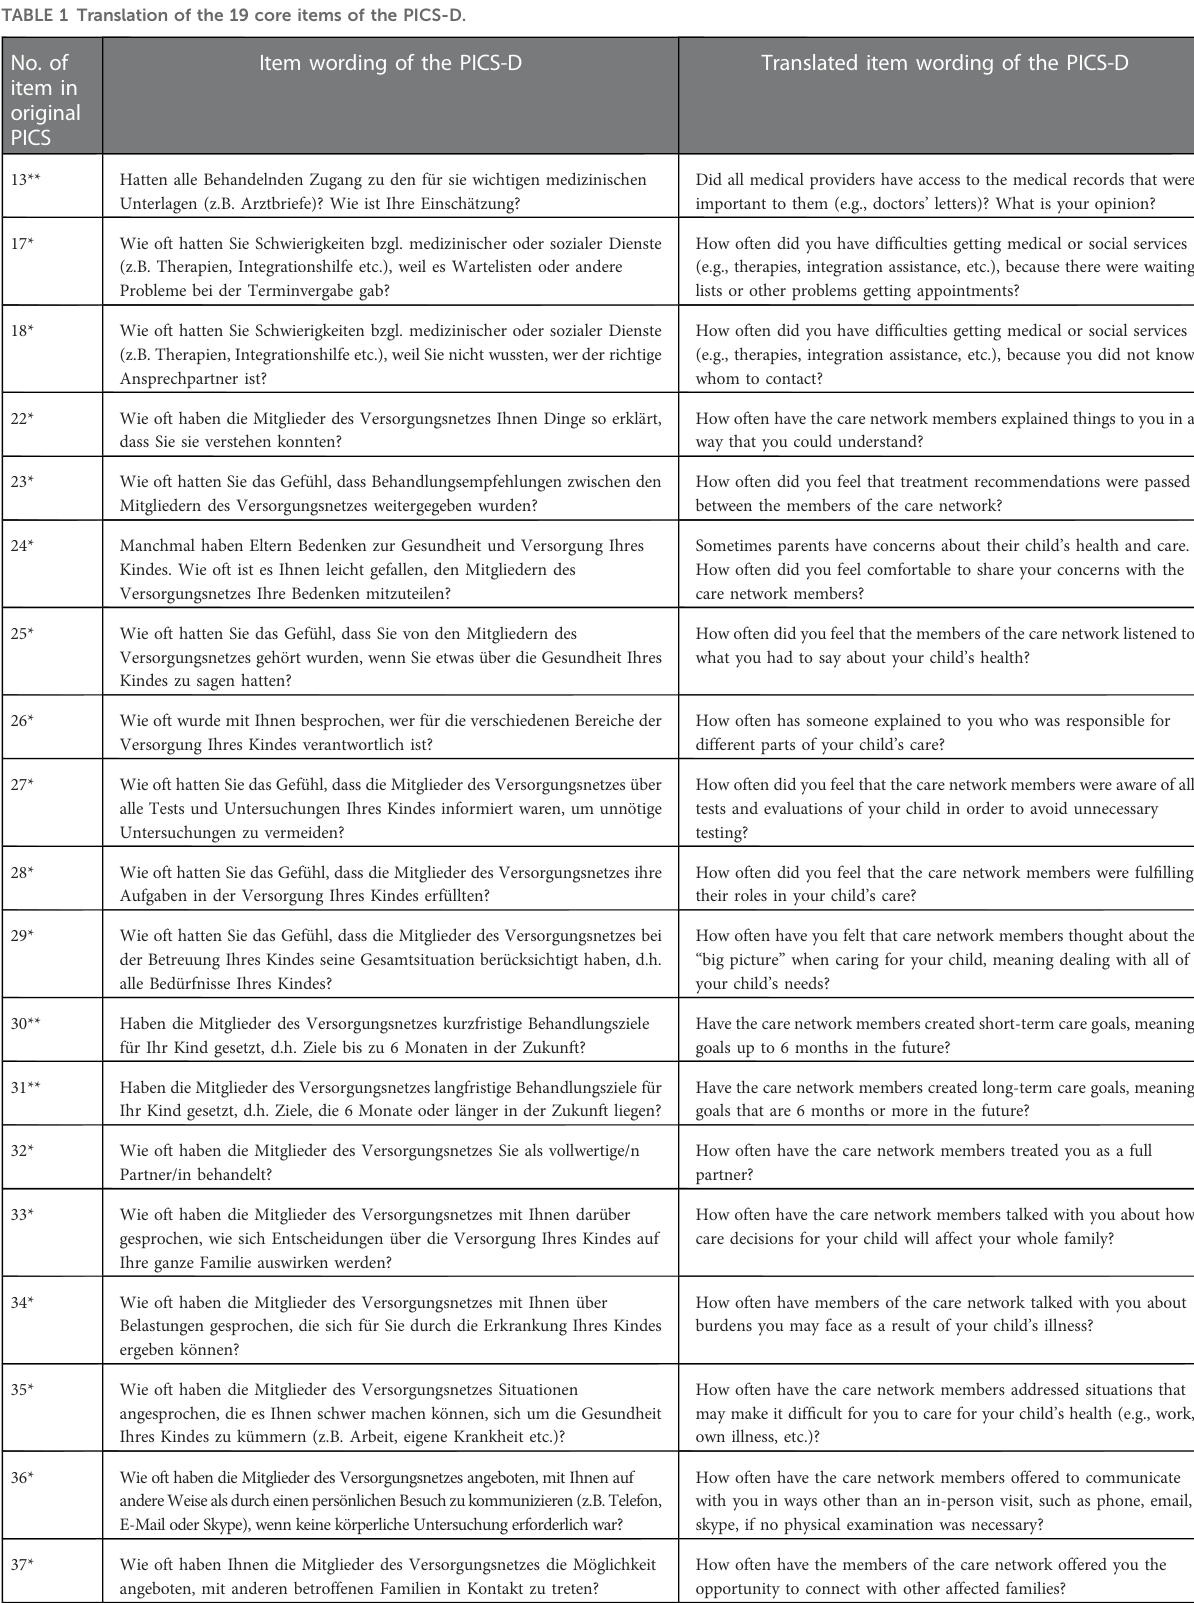
TABLE 1 Translation of the 19 core items of the PICS-D. No. of item